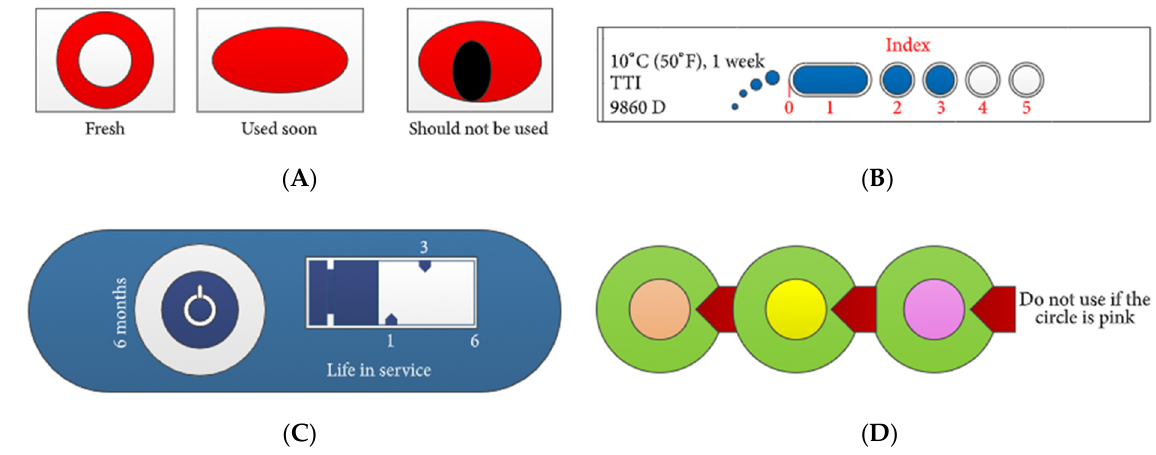
Figure 8. Schematic representation of the TTI, ( a ) Fresh-Check, ( b ) Timestrip, ( c ) MonitorMark, ( d ) CheckPoint, redrawn and reproduced with permission from [35]. Table 3. Comparison between different indirect freshness sensor